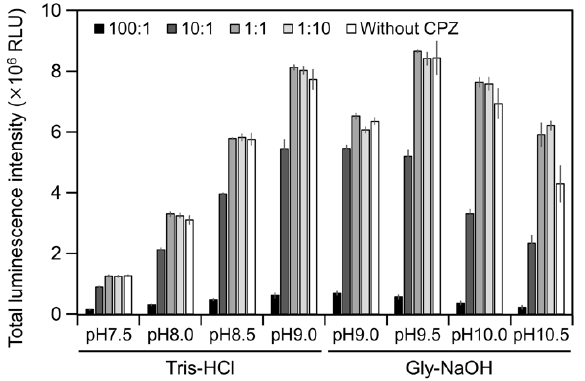
Figure 5. Luminescence intensity of Cypridina luciferin in the presence of hAGP with or without Chlorpromazine (CPZ) under various pH buffer conditions: the ratios indicate the molar ratio of CPZ to 6 pmol of Cypridina luciferin; without CPZ represents in the presence of only 6 pmol of Cypridina luciferin. The bars represent the mean values ± SD for n = 3.